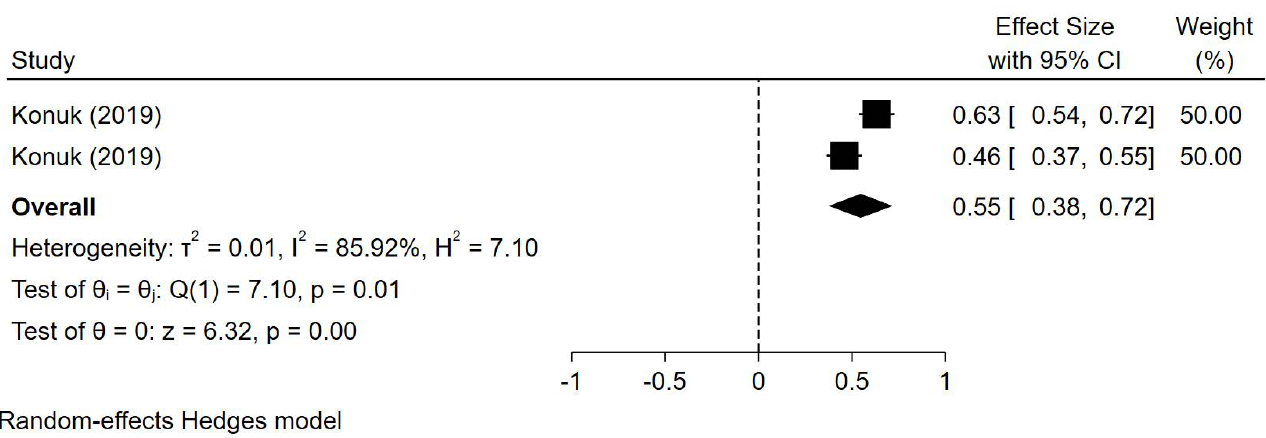
Figure 7. Meta-analysis of the association between ethical concern and consumer purchase behavior.